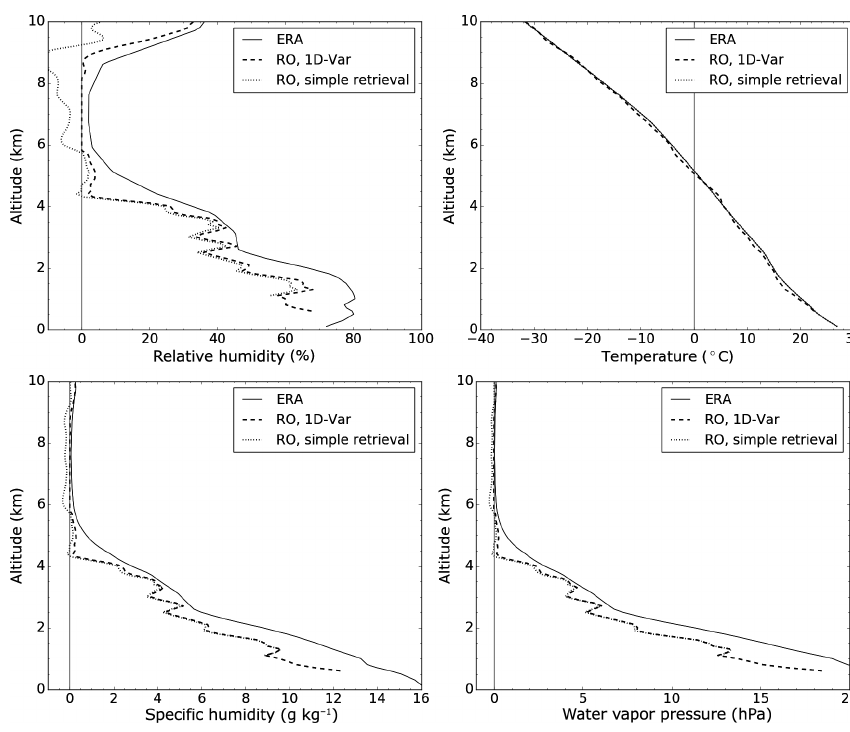
Figure A1. T , RH, q , and e profiles for ERA (solid, a priori), RO 1D-Var (dashed), and RO simple retrieval (dotted).